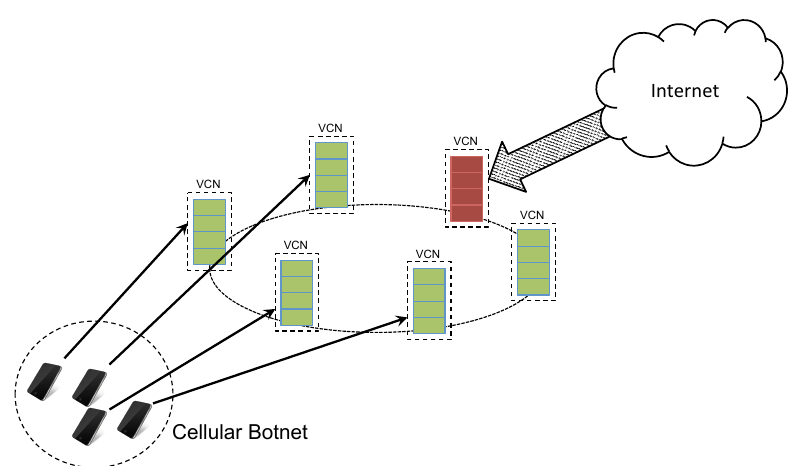
Figure 18. Attacks on the new